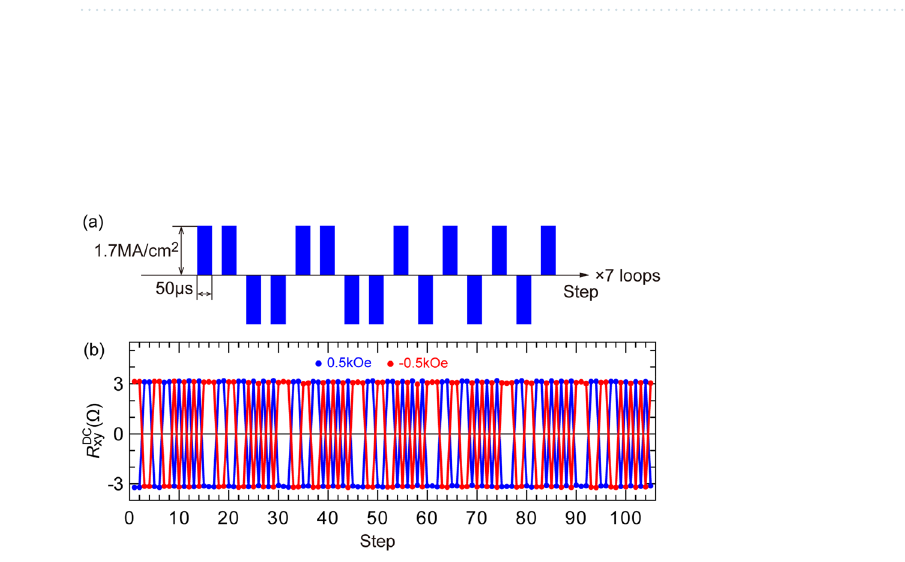
Figure 5. Ultralow current-induced magnetization switching in sample E ( σ YPtBi = 0.39 × 10 5 Ω −1 m −1 and t Co = 0.5 nm). ( a ) SOT magnetization switching by DC currents with various in-plane H ext (− 1.4 to 1.4 kOe) applied along the x -direction. ( b ) Threshold switching current density in YPtBi as a function of H ext . ( c ) SOT magnetization switching by pulse currents with various pulse width ranging from 50 μs to 10 ms and H ext of 0.5 kOe. ( d ) Threshold switching current density in YPtBi as a function of pulse width, where dots are experimental data and solid lines show fitting results given by Eq. (5).